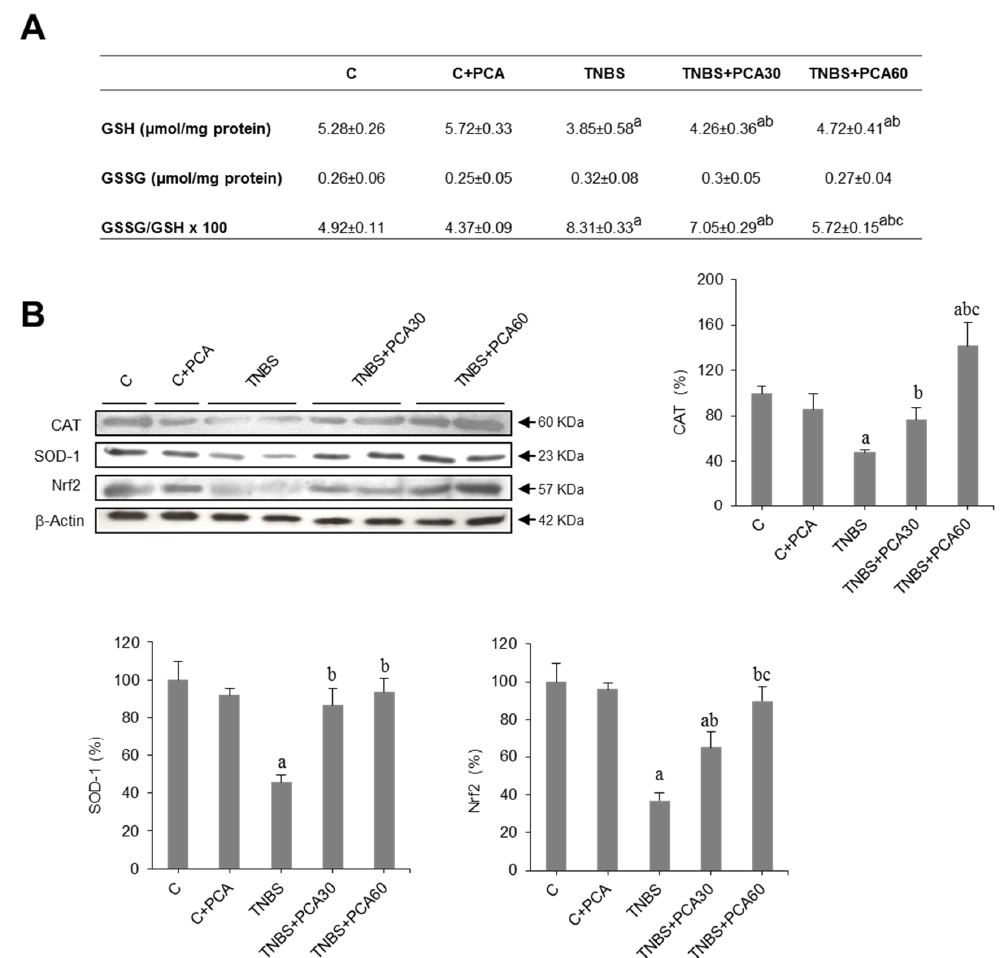
Figure 2. Effect of treatment with protocatechuic acid (PCA) on antioxidant status in mice with 2,4,6-trinitrobenzenesulfonic acid (TNBS)-induced colitis. Glutathione levels and GSSG/GSH ratio ( A ). Representative blots for CAT, SOD-1 and Nrf2 proteins, and results of densitometric quantification. ( B ). Values are expressed as the means ± SEM of six mice per group. a p < 0.05 vs. C group; b p < 0.05 vs. TNBS group; c p < 0.05 vs. TNBS + PCA30 group. Each assay was performed in triplicate.